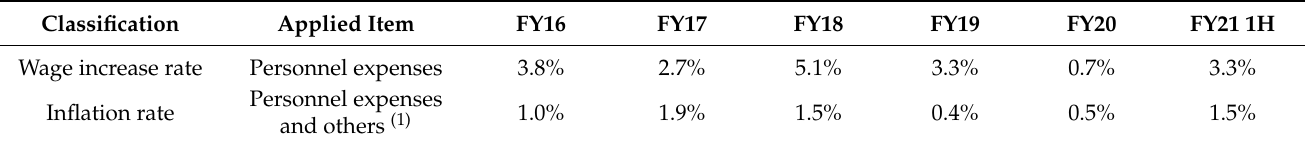
Table 10. Economic